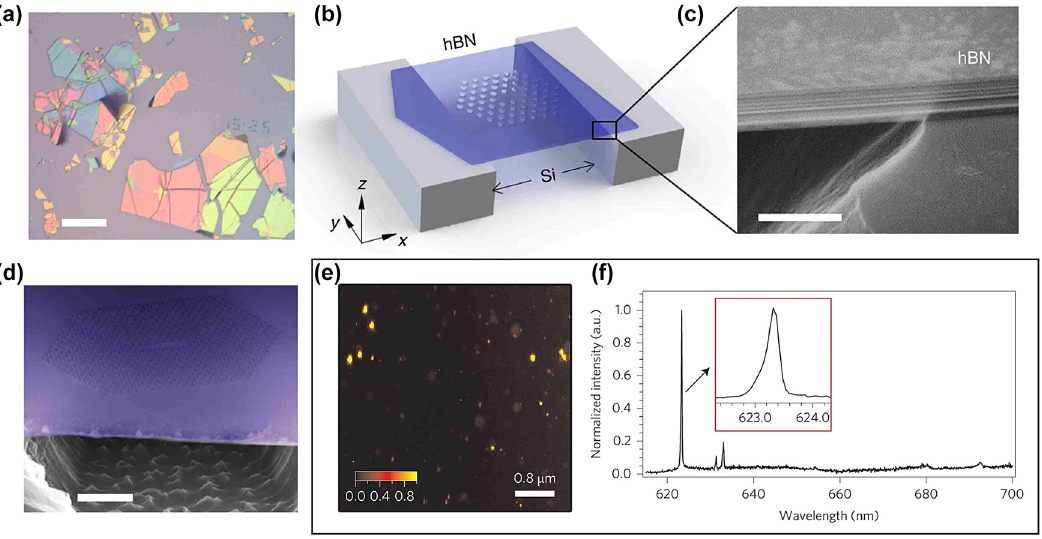
Figure 8: Quantum emitters in hexagonal boron nitride (hBN) and on-chip fabrication using hBN. (a) Optical image of hBN flakes, scale bar 50 μ m. (b – d) Schematic and SEM images of a photonic crystal cavity fabricated in a suspended multilayer hBN fl ake, scale bars: 500 nm in (c), 2 μ m in (d). Adapted from the study by Kim et al. [190], available under Creative